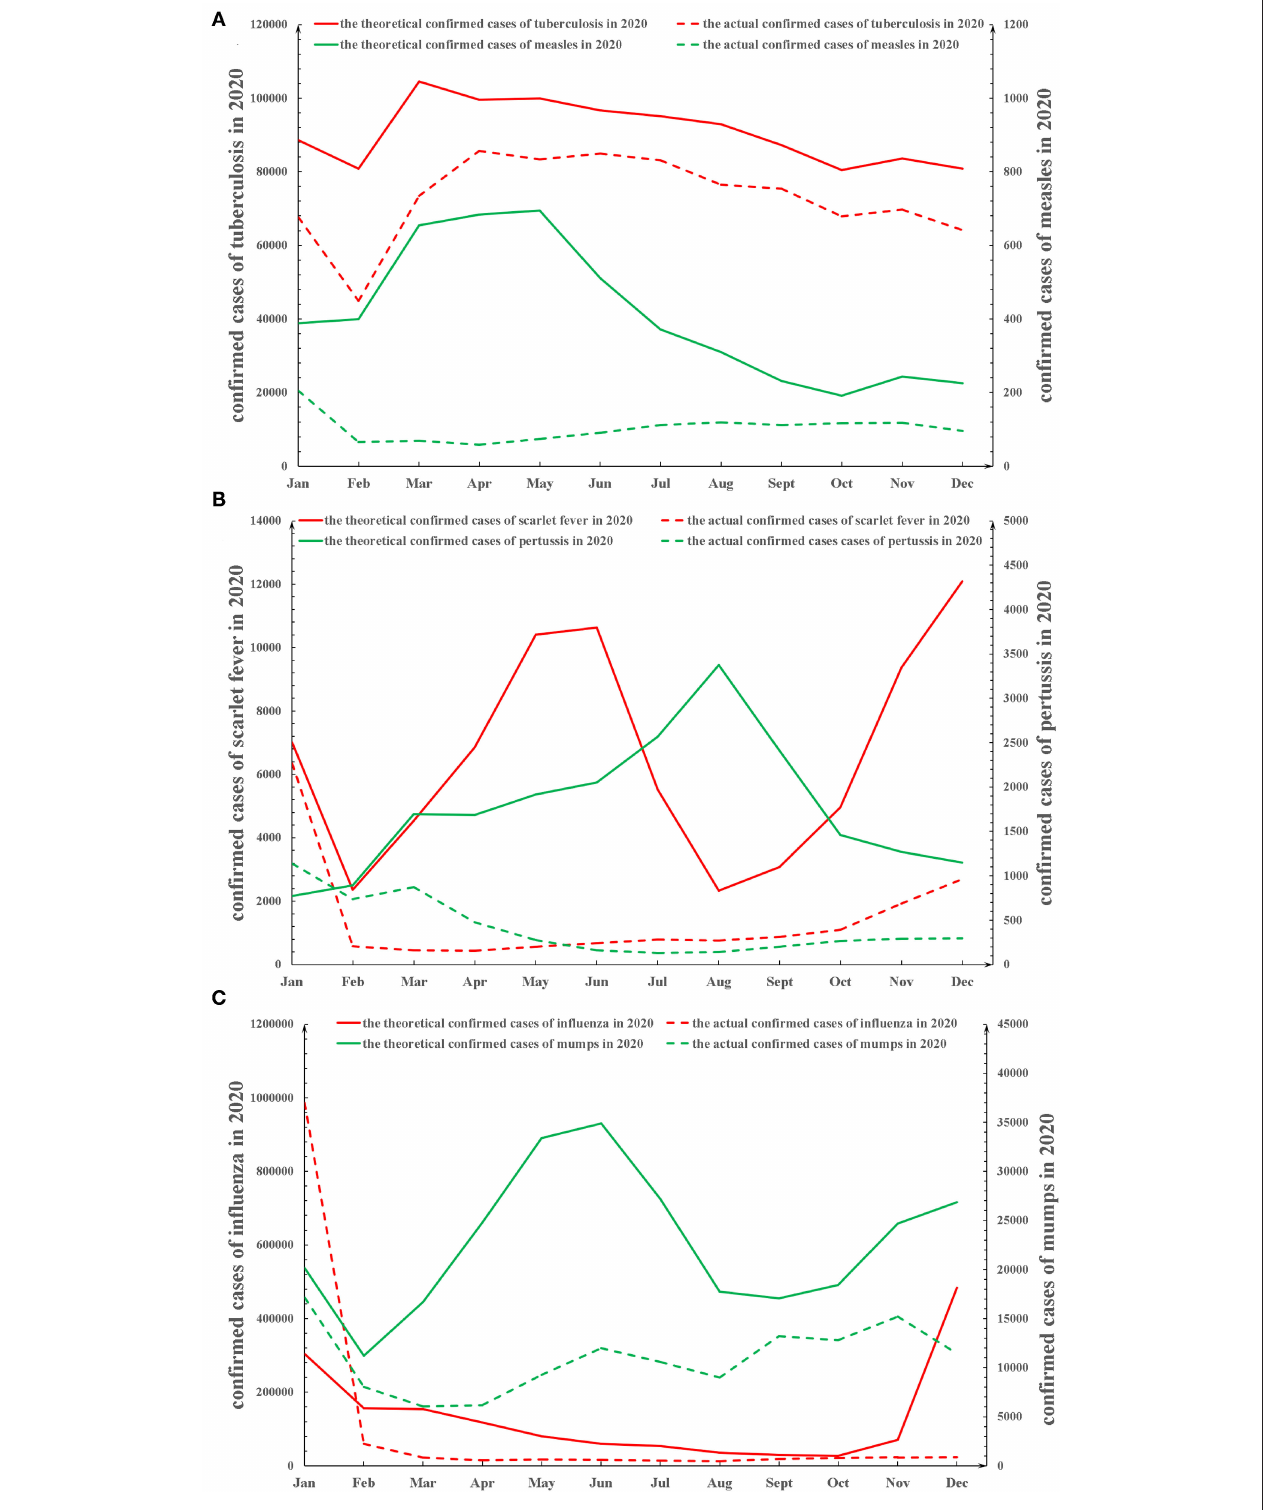
FIGURE 2 | The theoretical and actual trends of monthly new confirmed cases in the six respiratory infectious diseases in 2020 in China. (A) The theoretical and actual trends of monthly new confirmed cases in measles and tuberculosis in 2020 in China. (B) The theoretical and actual trends of monthly new confirmed cases in pertussis and scarlet fever in 2020 in China. (C) The theoretical and actual trends of monthly new confirmed cases in influenza and mumps in 2020 in China. The average of monthly number of newly confirmed cases from 2017 to 2019 was used to estimate the theoretical monthly number of newly confirmed cases expected